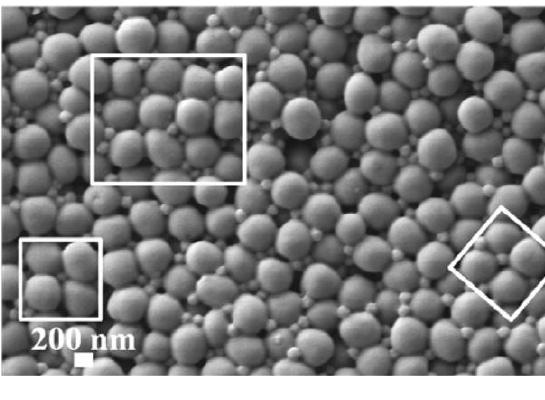
Figure 3. Cubic arrangement of heteroaggregated particles formed through H-bonding interactions (reproduced with permission from reference